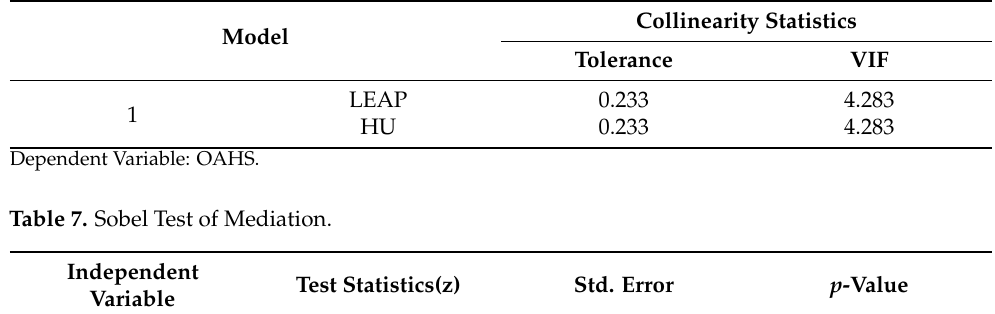
Table 6. Multi-collinearity Test.